Question: According to the figure, is the described quantity increasing or decreasing?
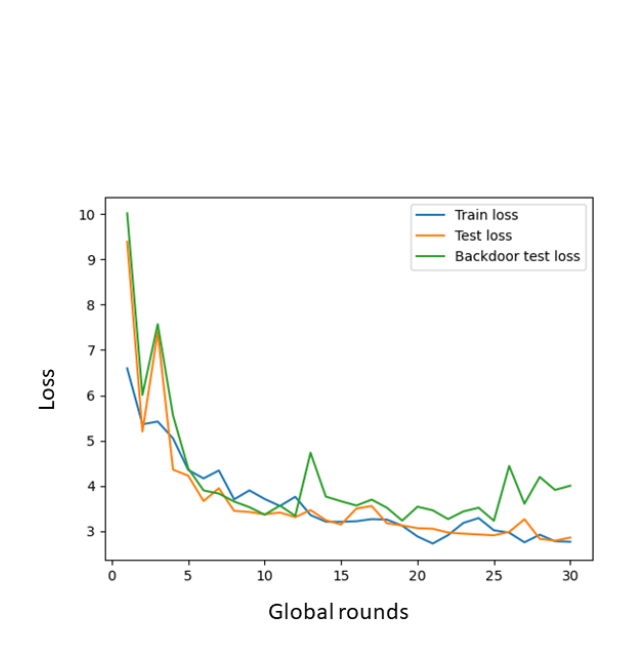
Answer: increasing